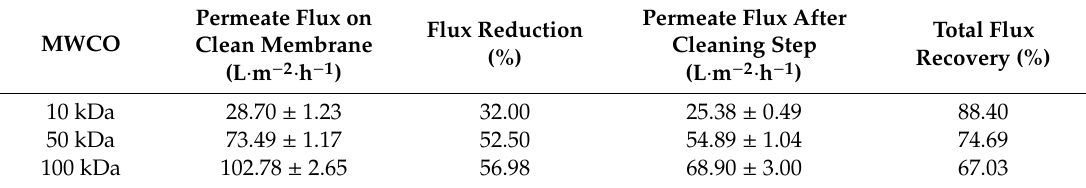
Table 4. Permeate flux, flux reduction, and total flux recovery after cleaning steps (relaxation and backwashing) from di ff erent molecular weight cut-o ff (MWCO)